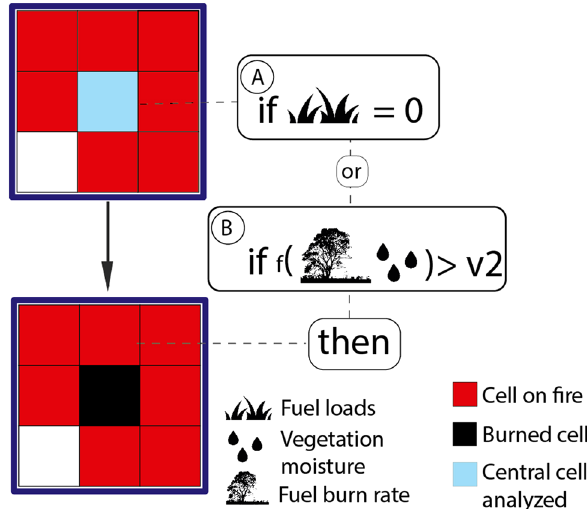
Figure 7. The fire extinction module. The algorithm tests whether the central cell on fire still holds fuel loads ( A ), or if the probability of fire extinction ( B ) given pE (Eq. 5) is greater than v2